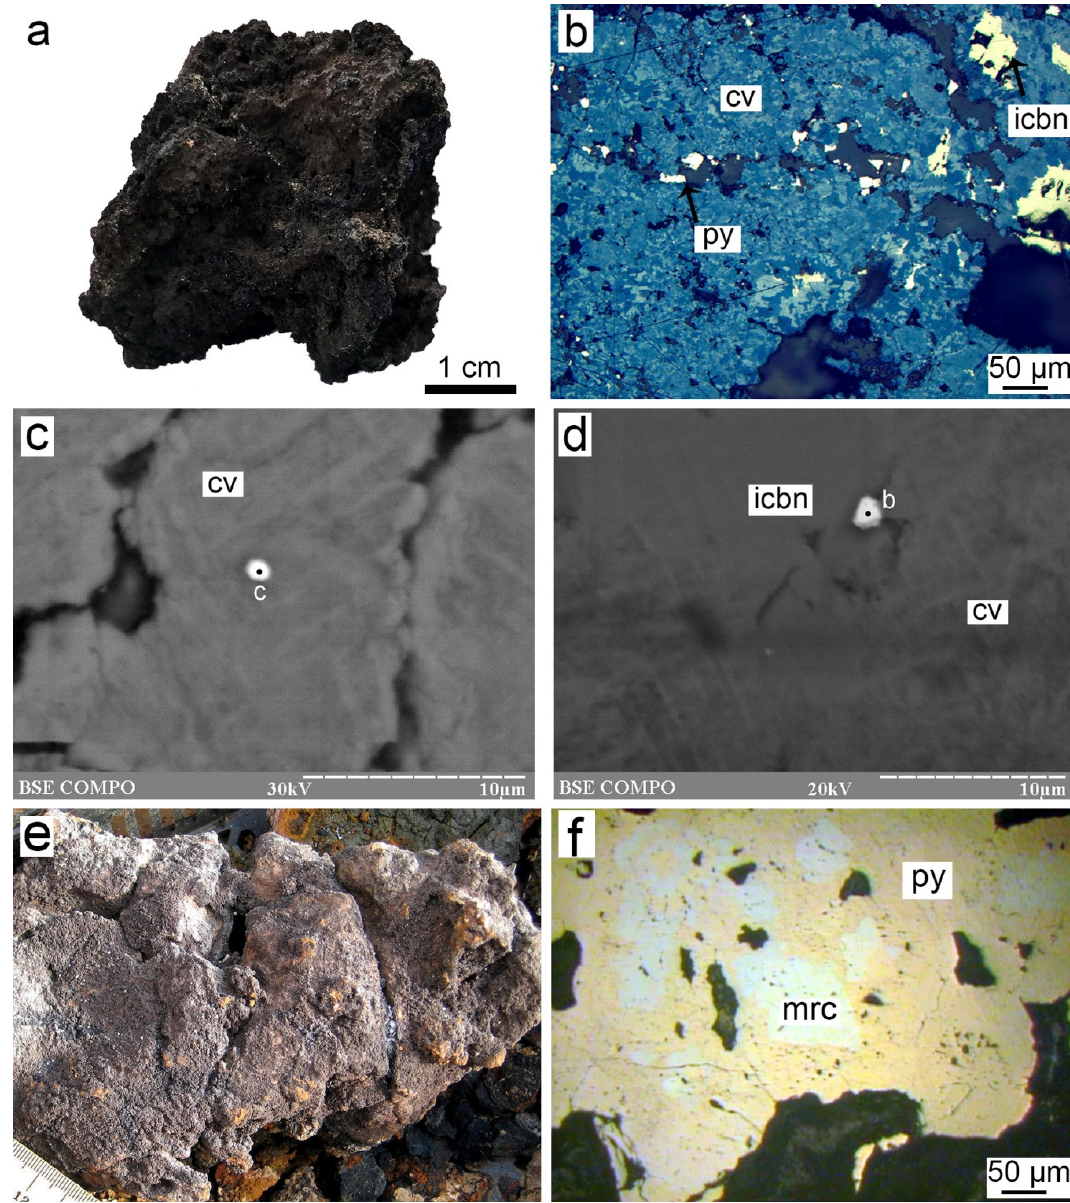
Figure 2. Cu-rich ( a ) and Cu-bearing Fe-rich ( e ) massive sulfide samples from station 233 (on-board photographs); crystalline isocubanite (icbn) almost completely replaced by covellite (cv) and overgrown by crystalline pyrite (py) ( b ); native gold in covellite ( c , point c) and at the isocubanite-covellite contact ( d , point b); zonal marcasite(mrc)–pyrite aggregates ( f ). Photos ( b , f ), reflected light; ( c , d ), SEM images. Hereinafter, the mineral abbreviations follow the recommendations of [30], except for isocubanite, native gold, and clausthalite (see